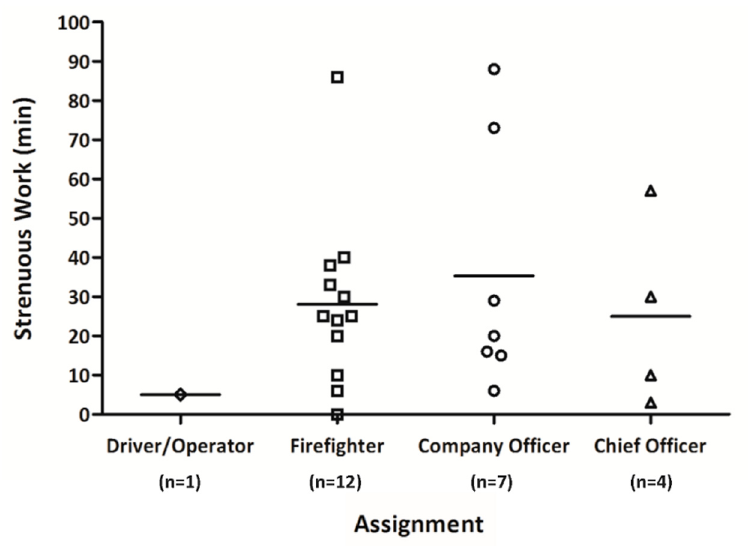
Figure 3. Distribution of time (min) spent performing strenuous work on-scene prior to the onset of symptoms at structure fires by assignment among cardiac fatalities investigated by NIOSH for incidents that occurred 9 January 2008–10 February 2017 (N = 24). Note, no assignment was made for one pending investigation.